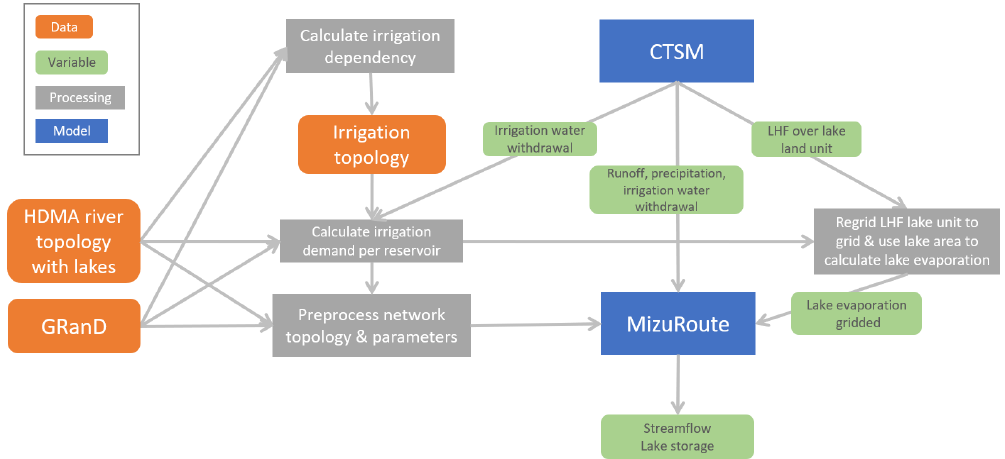
Figure 2. Schematic representation of the modelling workflow for the global-scale mizuRoute application using input data and parameters based on Community Land Model (CLM) simulations. LHF refers to latent heat